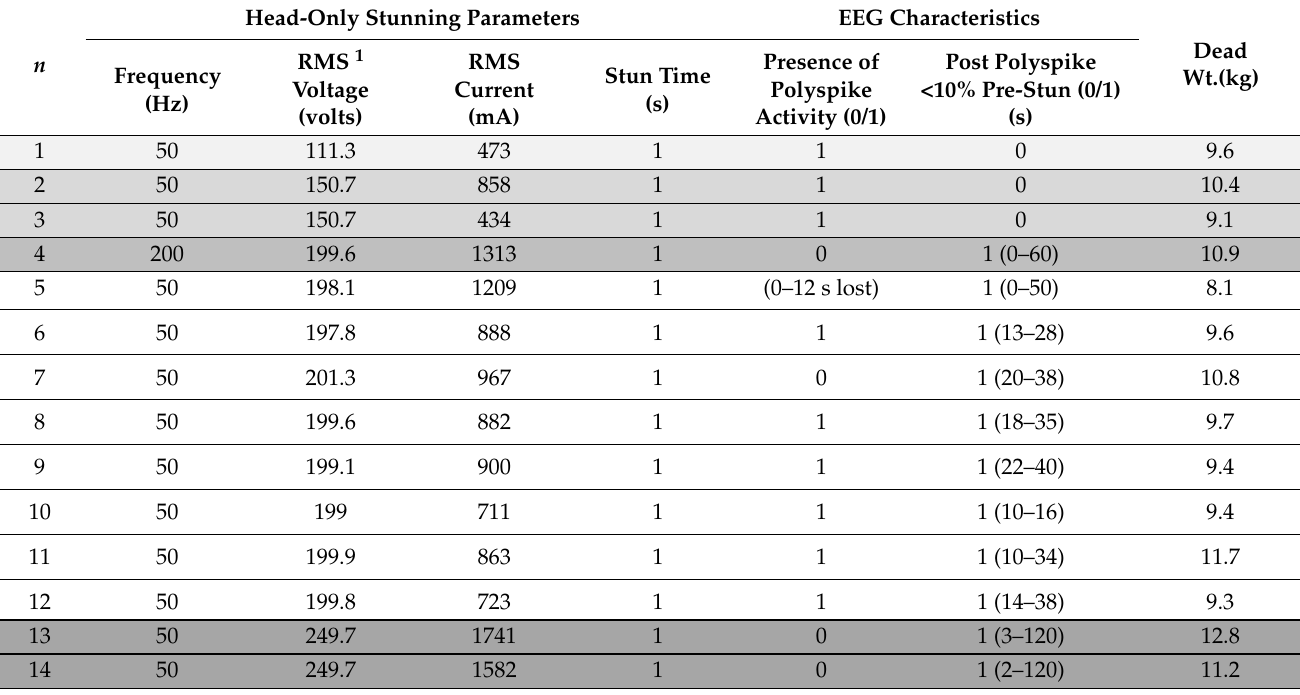
Table 7. The effect of increased voltage and reduced frequency on the induction of epileptiform activity in the electroen- cephalogram (EEG) in